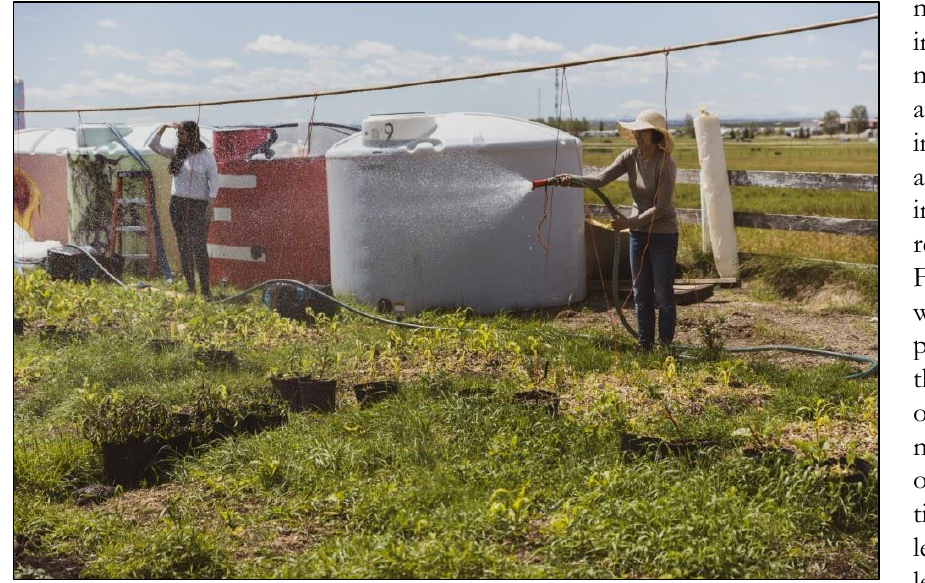
Figure 2. Watering Young Corn, Beans, and Squash